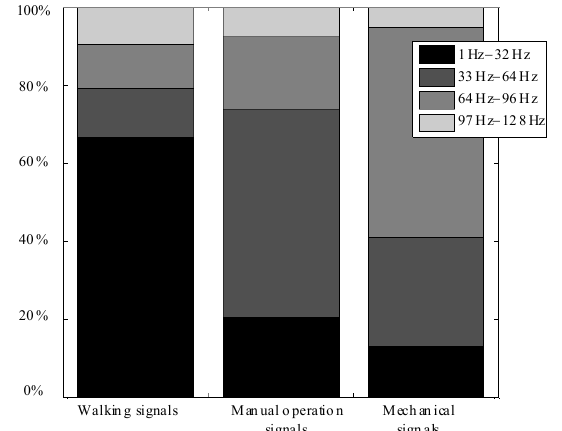
Fig. 4 Distribution of energy ratio in 4 frequency bands.